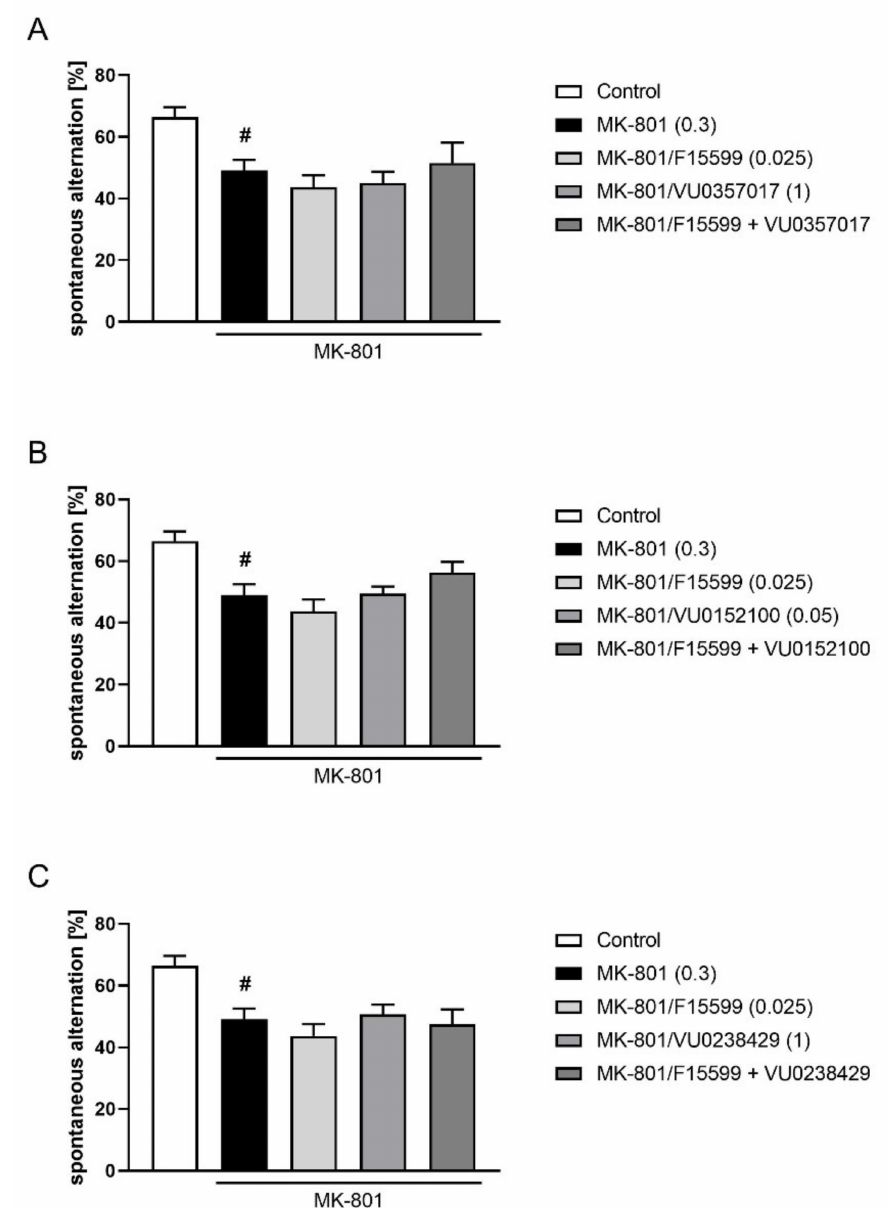
Figure 12. Activity of combined administration of subeffective dose of F15599 with subeffective dose of VU0357017 ( A ), VU0152100 ( B ), or VU0238429 ( C ) in the Y-maze test after seven days of treatment. The data are presented as means ± SEM. Doses of the compounds are indicated in parentheses. # p < 0.01 compared to control